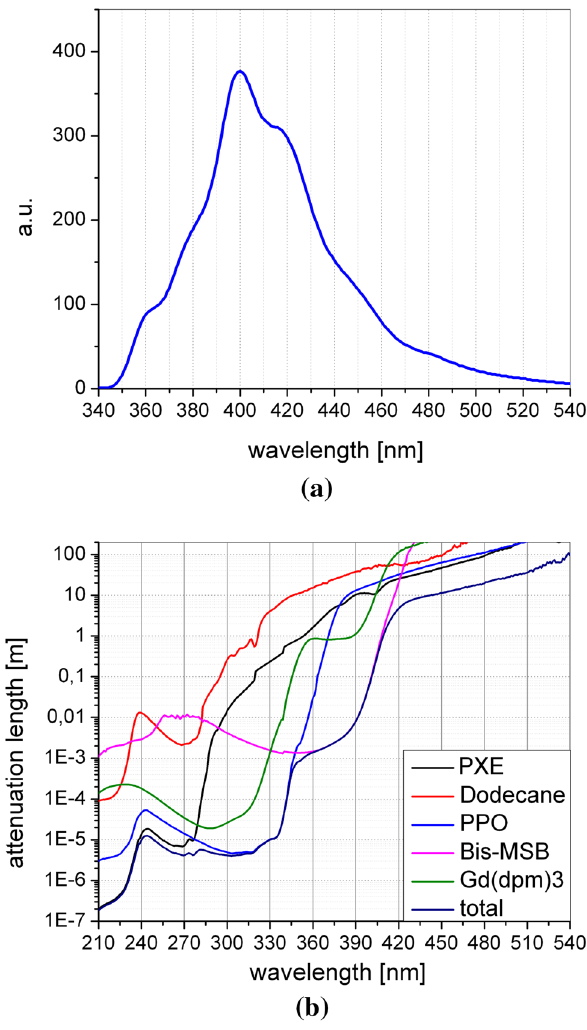
Fig. 7 a Primary scintillator emission spectrum of the Double Chooz Target measured in a triangular cell. b Contributions of Target compo- nents to the total attenuation length. The absorption above 420 nm is dominated by optical impurities in the